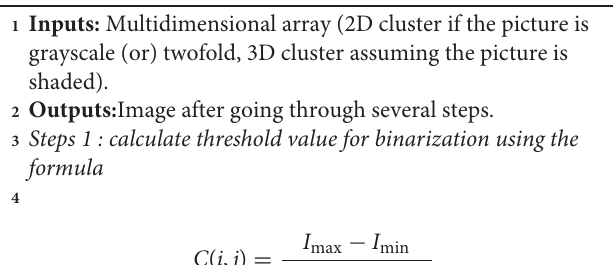
Algorithm 1: Pre-processing phase.